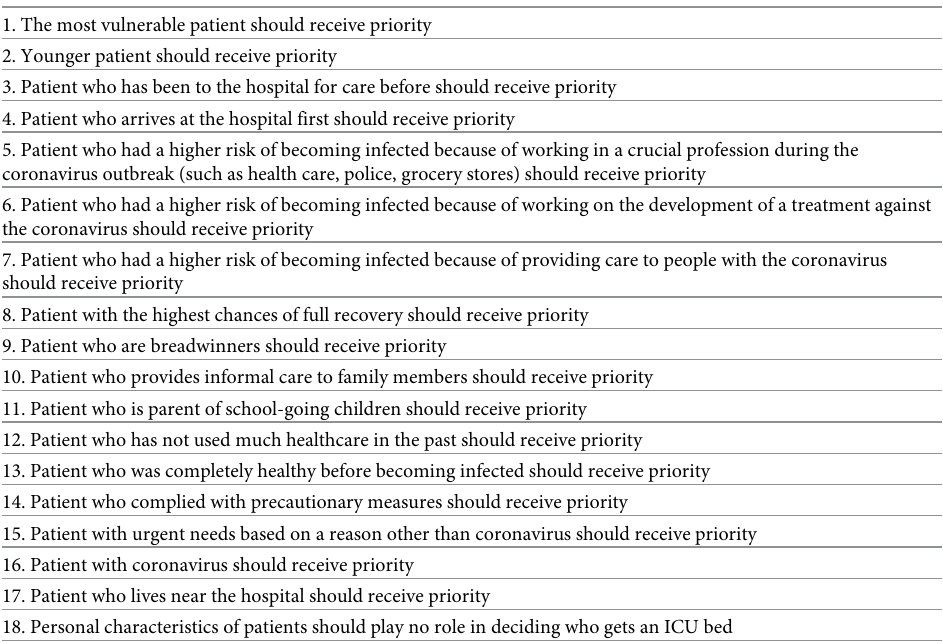
Table 2. Potential criteria for rationing ICU